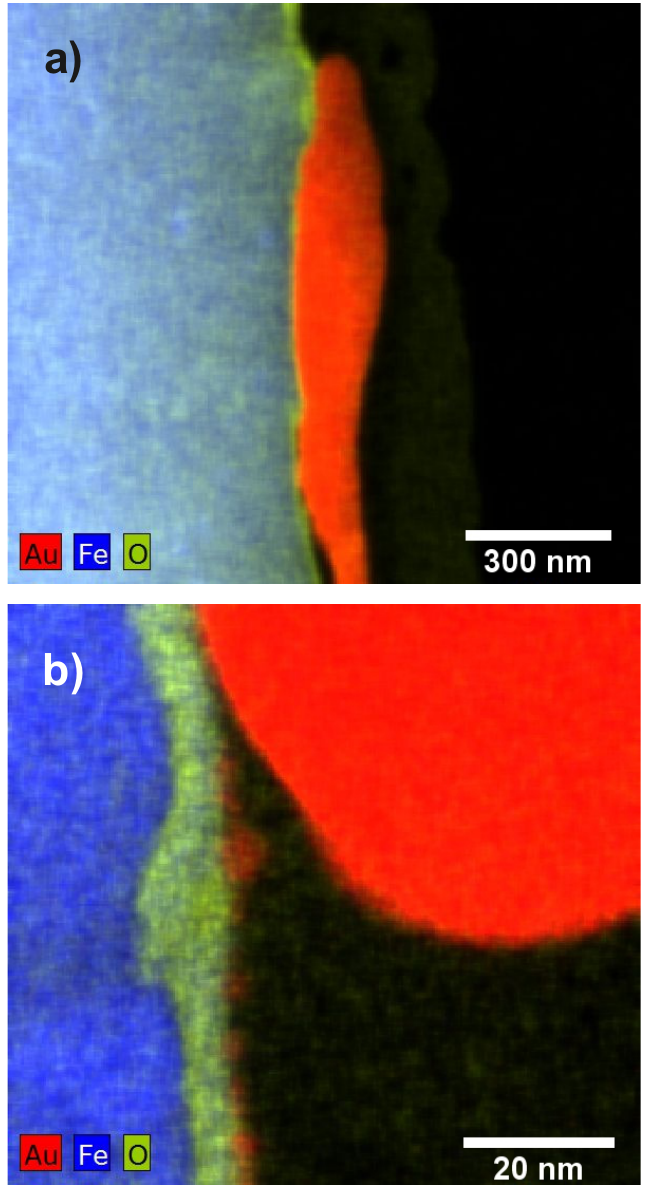
Figure 4. ( a ) STEM EDX mapping of the sample “Au”; ( b ) EDX mapping acquired with higher magnification showing an oxide layer on top of the steel substrate. Additionally to the edge of a large Au particle, Au nanoparticles are seen at the